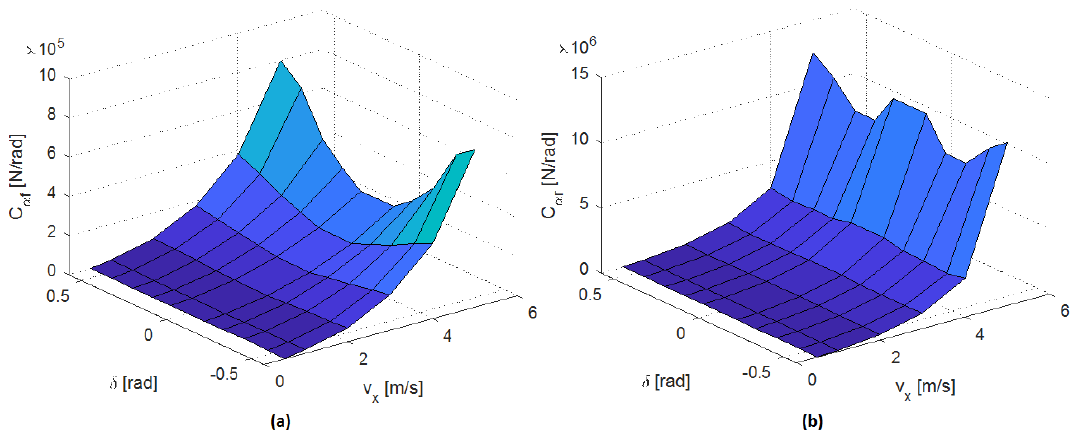
Figure 8. ( a ) Front and ( b ) rear cornering stiffness estimation